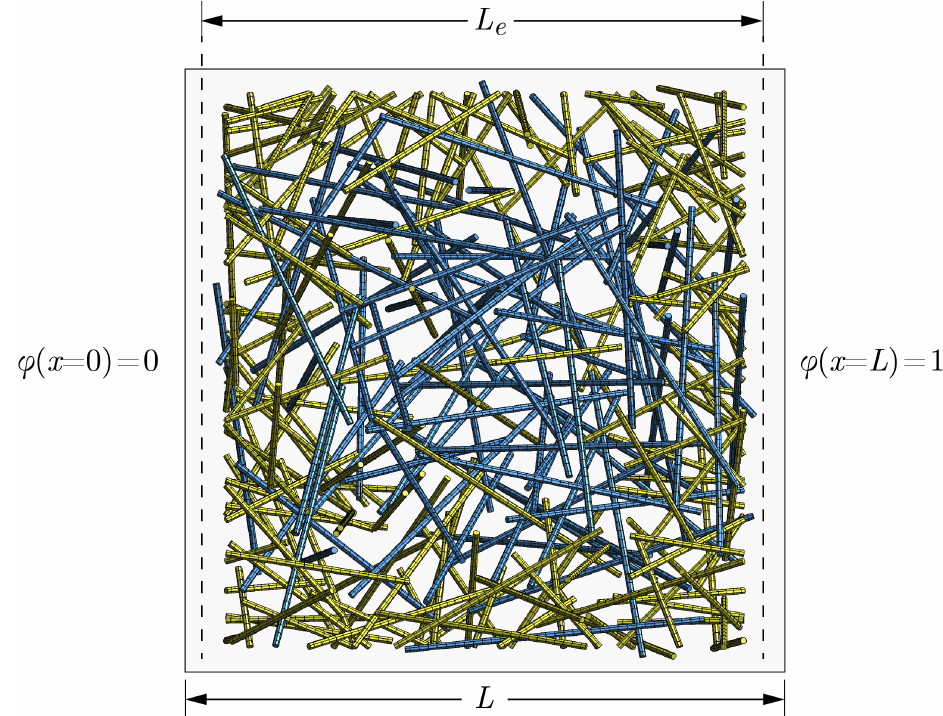
Figure 5. Profile view of fiber distribution within the 3D unit cell.